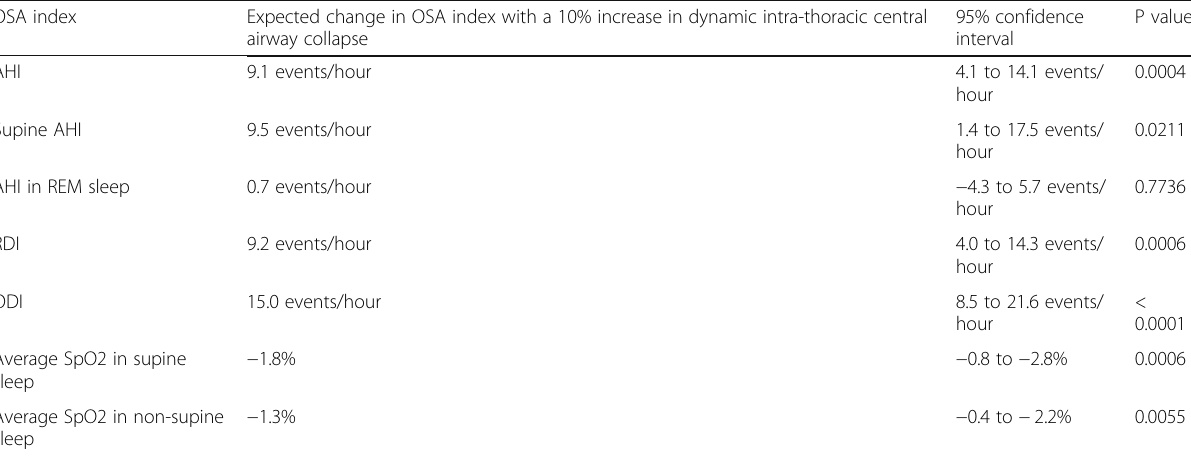
Table 3 Unadjusted linear regression models assessing associations between intra-thoracic central airway collapse and obstructive sleep apnoea